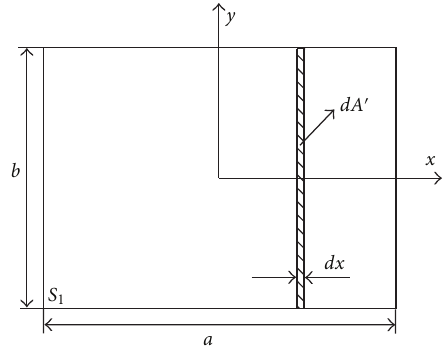
Figure 5: Di ff erential area ( dA (cid:3) = b dx ) on surface S 1